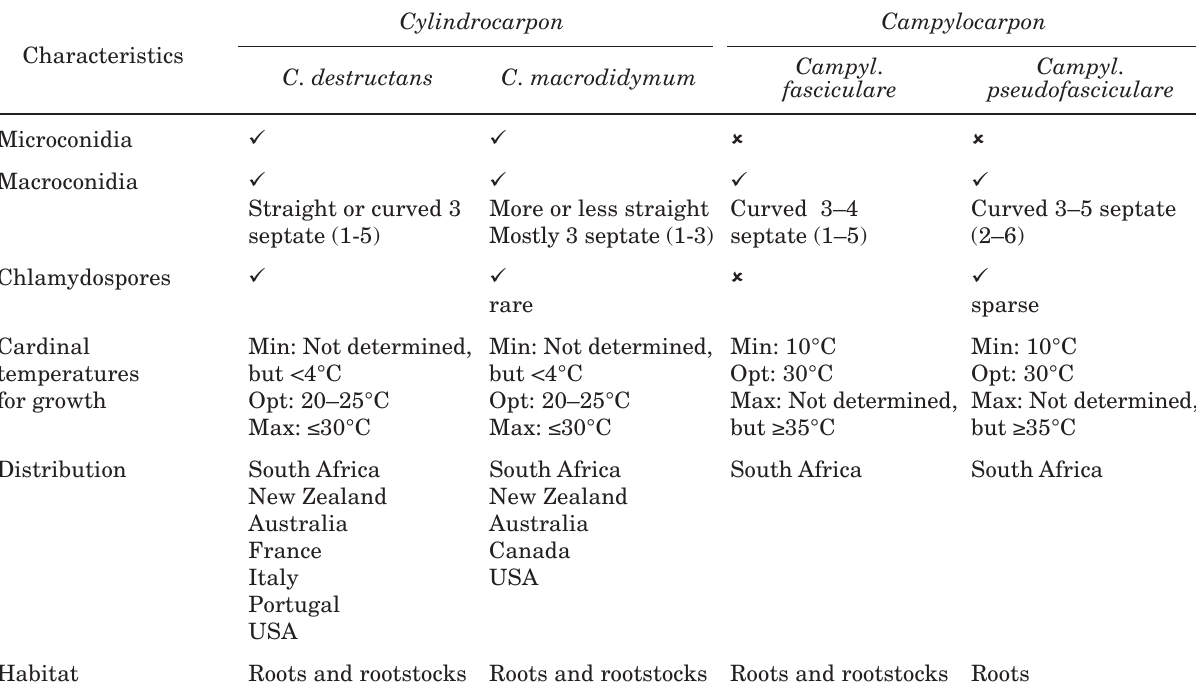
Table 1. Summary of morphological and cultural differences between, and geographical distribution of Cylindrocar- pon and Campylocarpon species associated with black foot disease of